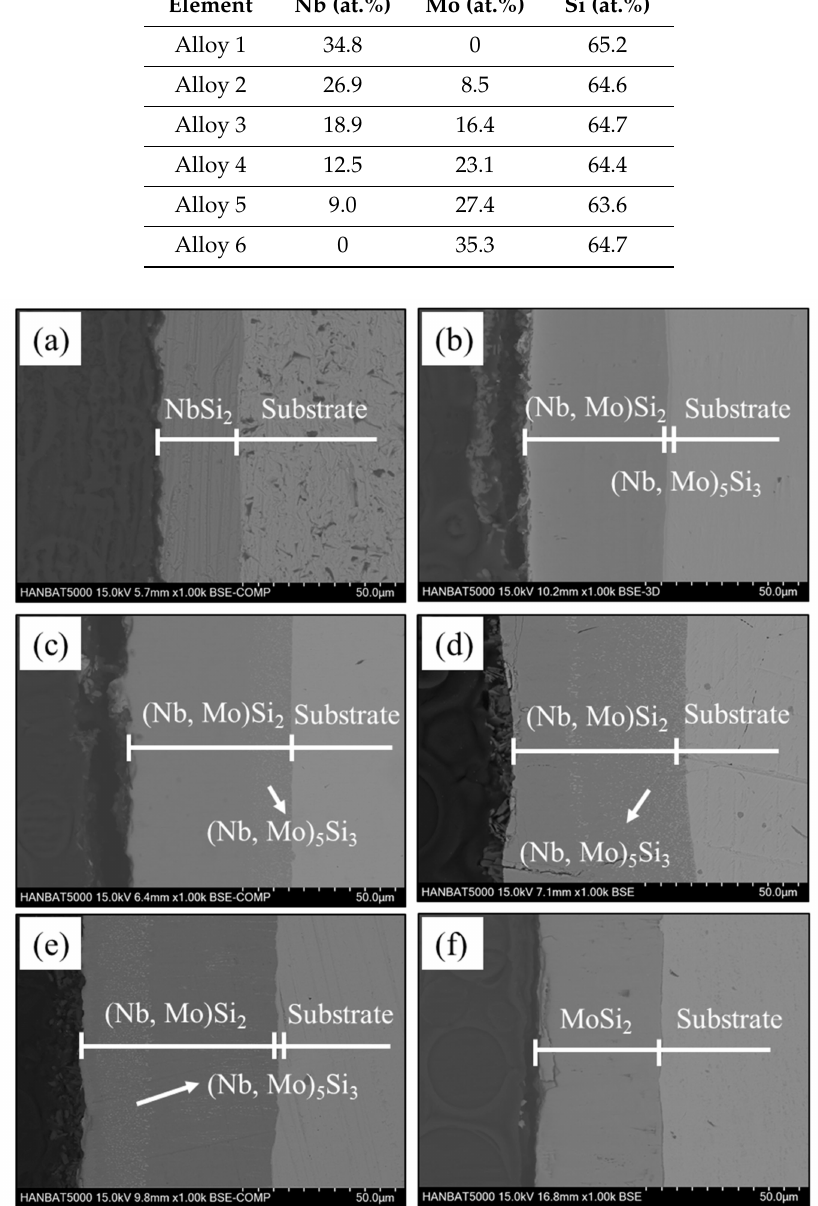
Figure 2. SEM BSE image of cross sections of Si-pack-coated specimens at 1100 ◦ C for 24 h showing the formation of (Nb x , Mo y )Si 2 and (Nb x , Mo y ) 5 Si 3 coating layers on the surface with substrate compositions of ( a ) Alloy 1 (Nb), ( b ) Alloy 2 (Nb 73.6 Mo 26.4 ), ( c ) Alloy 3 (Nb 51.2 Mo 48.8 ), ( d ) Alloy 4 (Nb 35.1 Mo 64.9 ), ( e ) Alloy 5 (Nb 25.7 Mo 74.3 ), and ( f ) Alloy 6